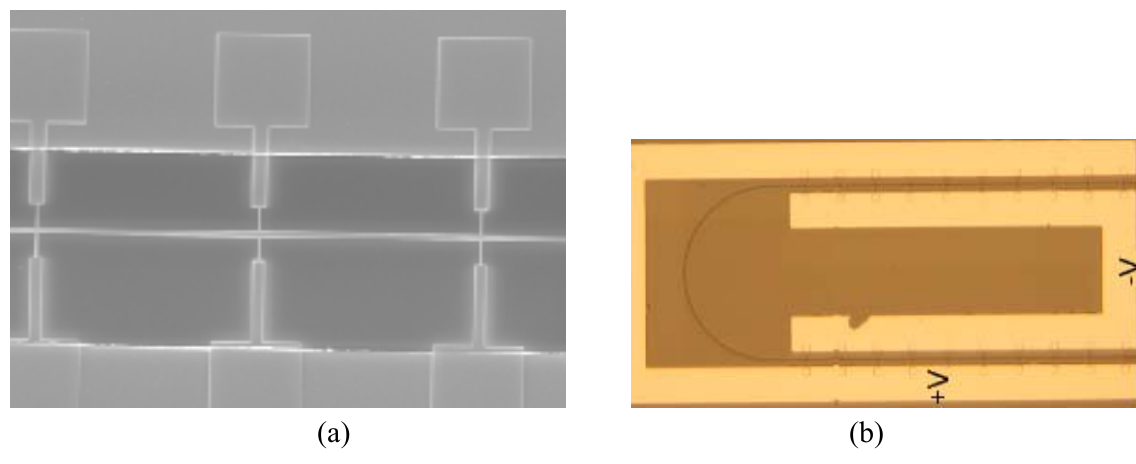
Figure 12. Top view SEM image (a) and optical image (b) of the detector proposed by Baehr-Jones et al. [61]. Copyright © 2008 Optical Society of